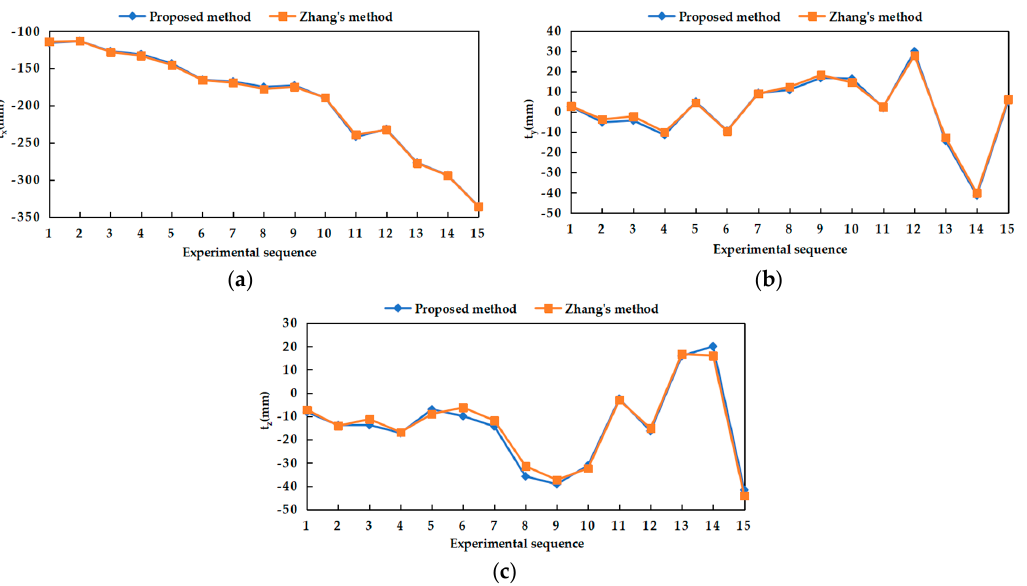
Figure 11. Translation vector between two cameras obtained by our proposed and Zhang ʹ s methods: